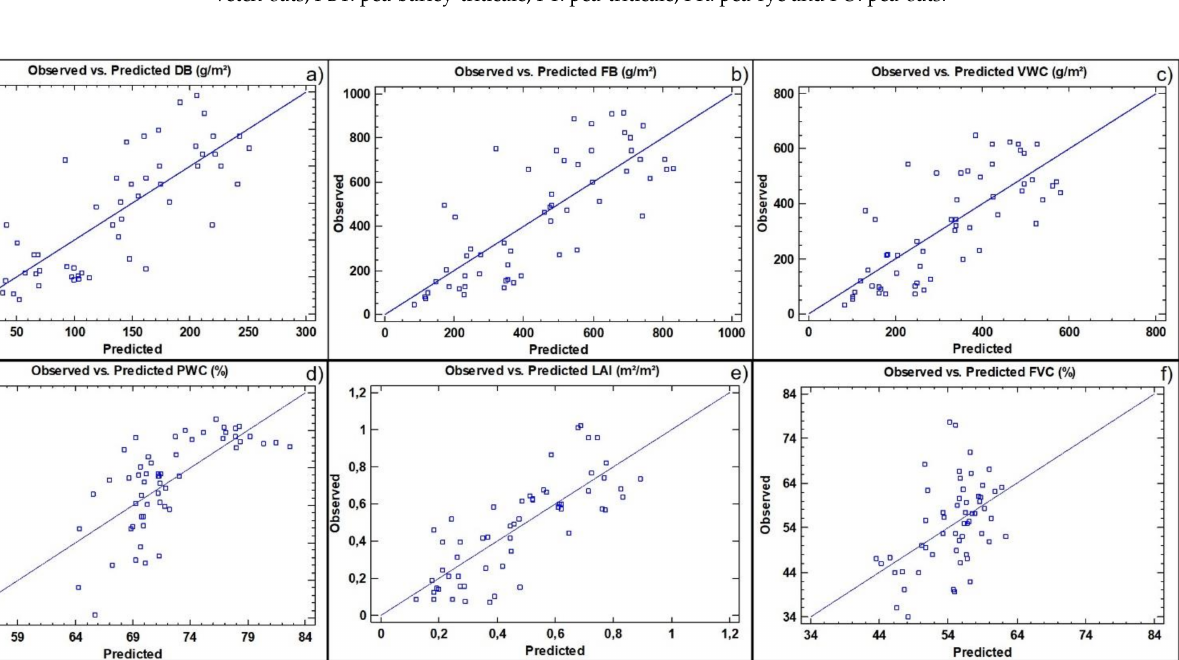
Figure 6. Observed vs. predicted values for the six response variables of VBT, VT, VR, VO, PBT, PT, PR and PO associations in a four-component model. ( a ) FB: fresh biomass, ( b ) DB: dry biomass, ( c ) VWC: vegetation water content, ( d ) PWC: percentage of water content, ( e ) LAI: leaf area index and ( f ) FCV: fraction of vegetation cover. VBT: vetch-barley-triticale,